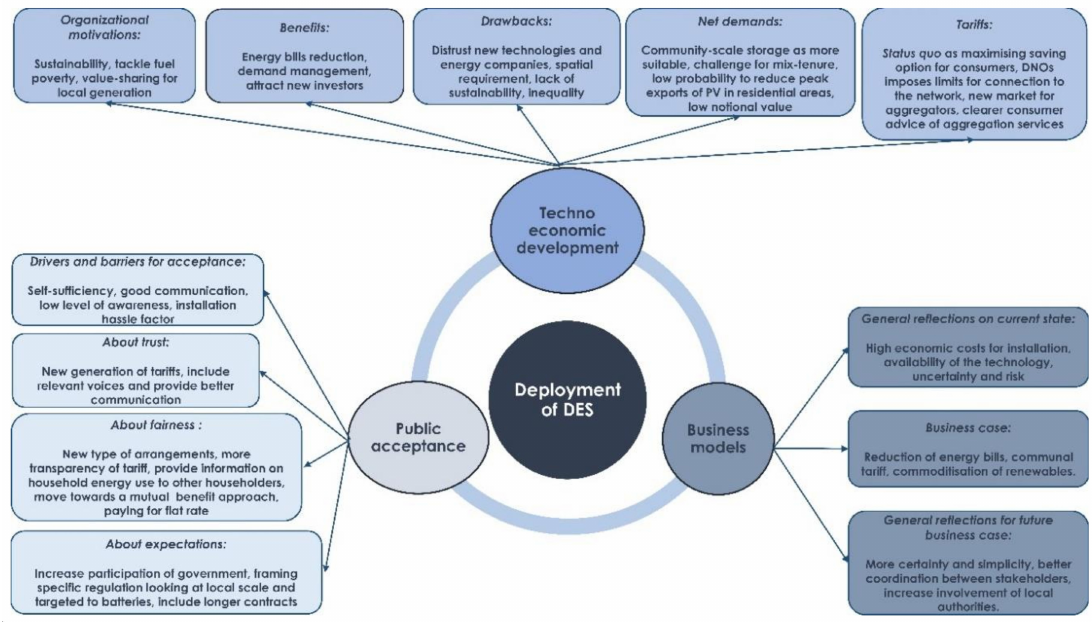
Figure 1. Summary of